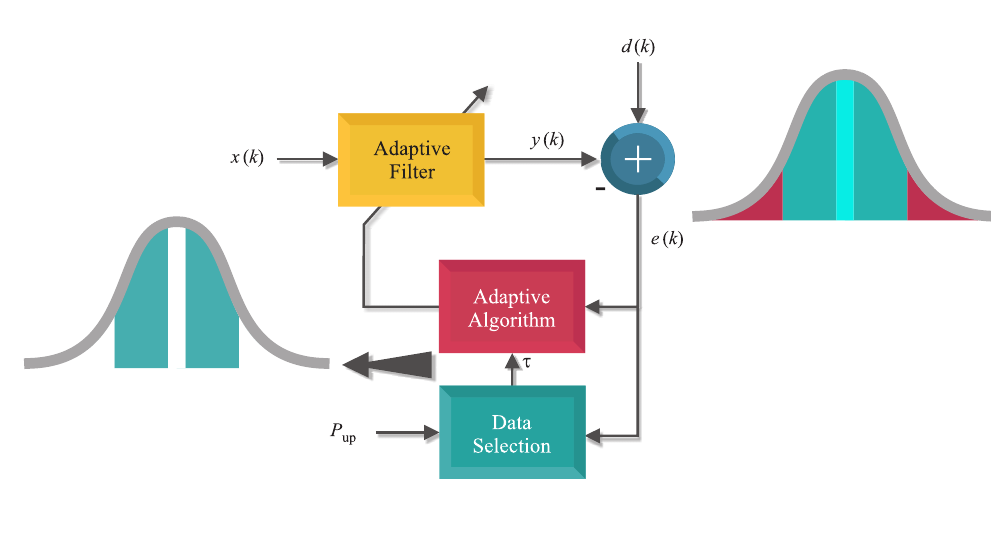
Figure 1. Data selection